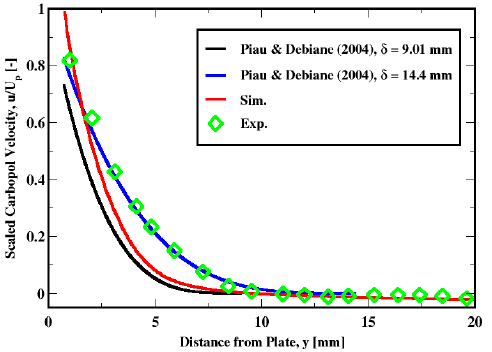
Figure 10. Predictions of the velocity distribution using Piau and Debiane (2004) model for a prescribed boundary layer thickness.